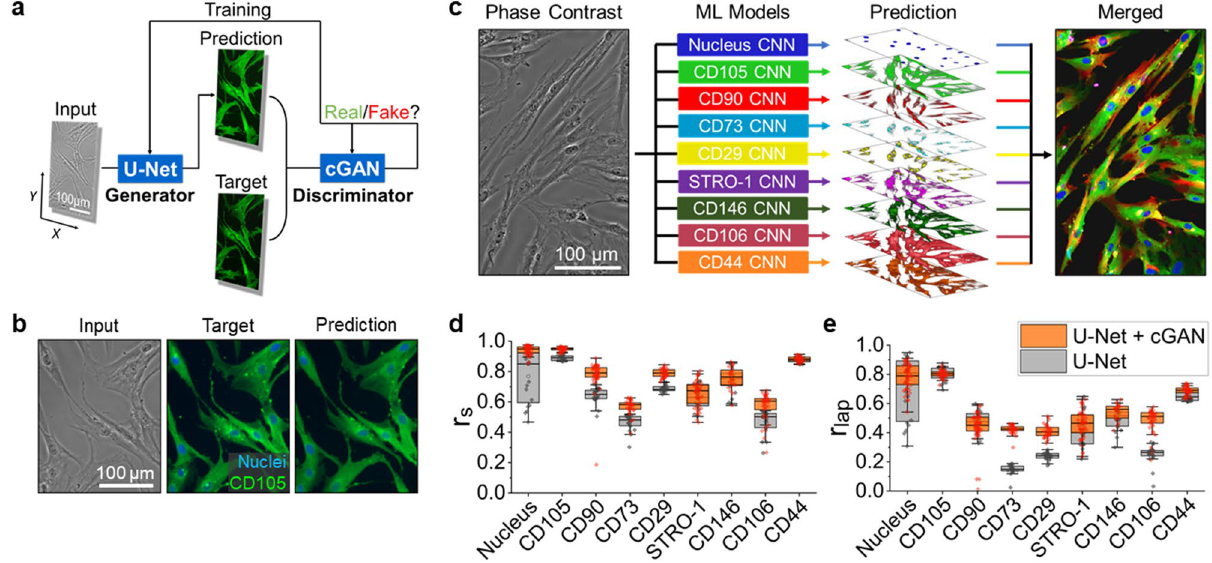
Figure 1. Convolutional neural network (CNN) training for predicting marker expression. ( a ) Schematic of an iterative machine learning training operation. The generator produces a virtually stained prediction image using a U-Net architecture. The discriminator measures the probability of similarity between prediction and target and updates loss function parameters. ( b ) Left to right: example of a phase contrast input image, a target (ground truth) immunofluorescence image and the respective prediction image. ( c ) Individually trained marker predictions from a single transmitted light microscopy image combined into a multi-marker composite. ( d , e ) Performance of virtual surface marker prediction using the U-Net + cGAN model (orange) versus the U-Net only model (grey). Both ( d ), the Source Pearson correlation coefficient r s , and ( e ), the Laplacian Pearson correlation coefficient r lap , demonstrate higher values over all channels. Each data point represents one target- prediction image pair, with outliers shown as diamonds. Boxplots were created by using OriginLab version